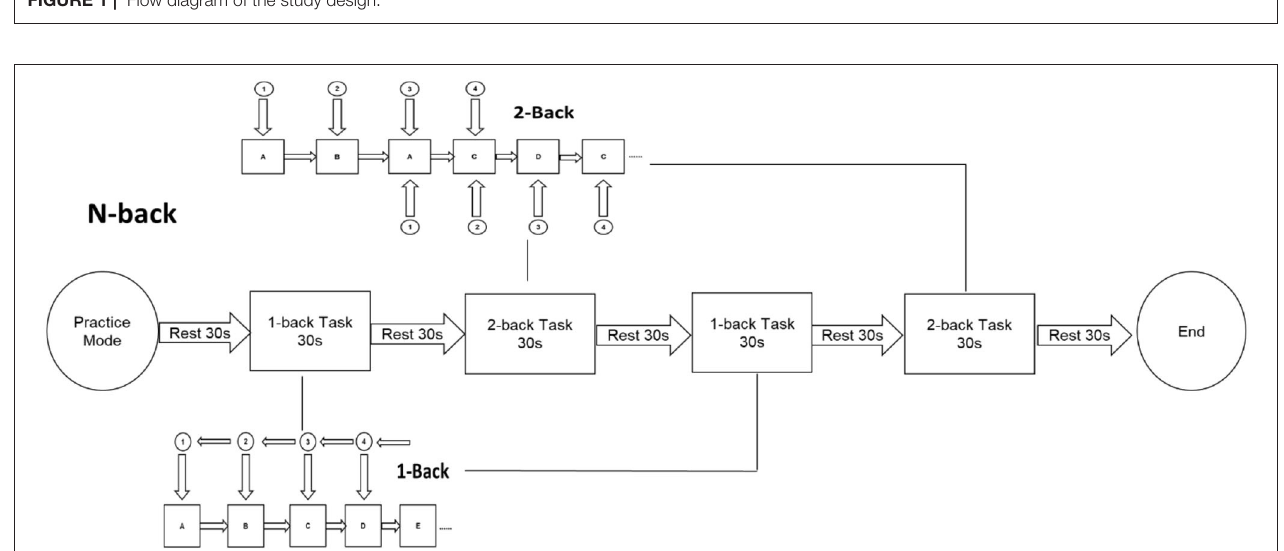
FIGURE 2 | N-back task flow